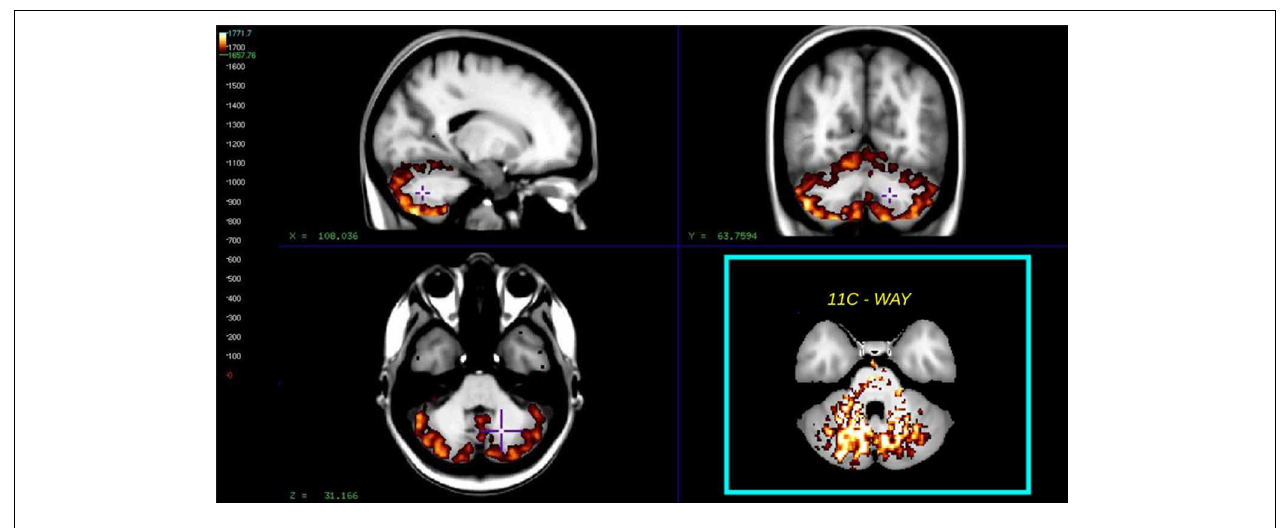
registered average MRI brain, the cyan insert shows the similar reference region for the way compound as found in Møller et al. (2009).